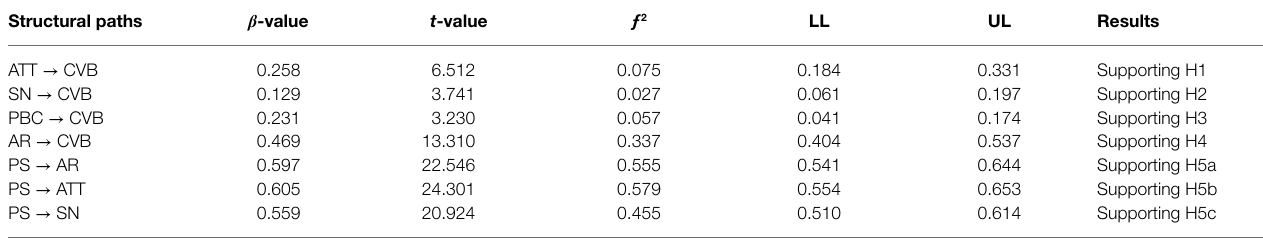
TABLE 5 | Structural paths assessment (Hypothesis